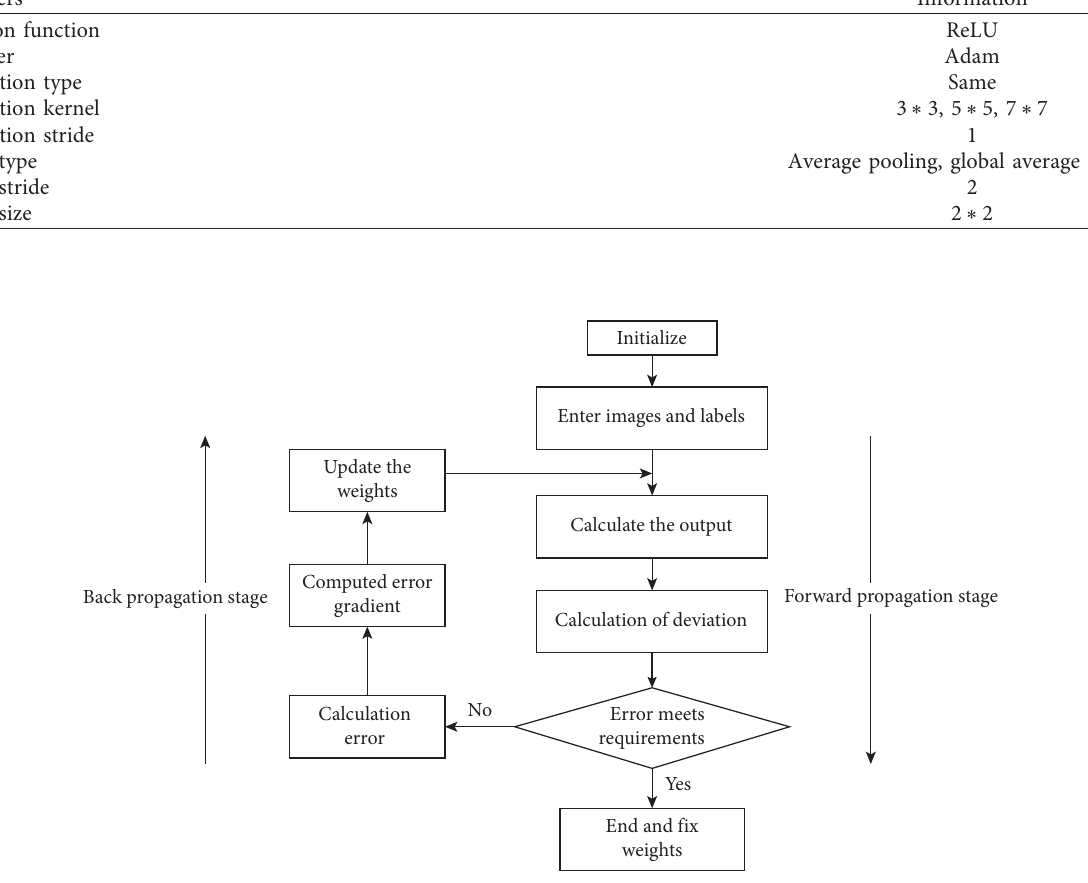
Figure 8: The flowchart of model